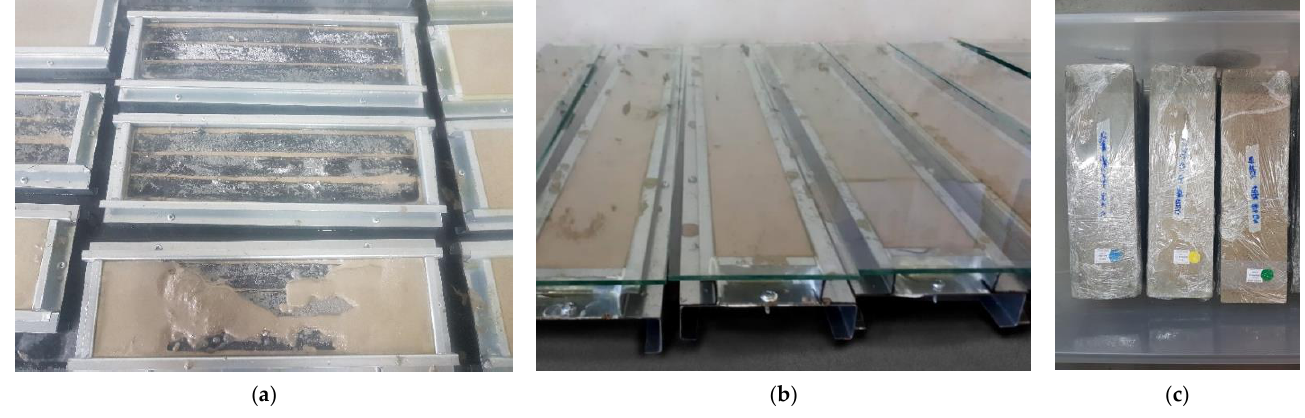
Figure 3. ( a ) The preparation of samples: bottom lightweight concrete layer according to the level marked on the metallic form, positioning of polyester strips, and filling of top lightweight concrete layer; ( b ) closed form with glass; ( c ) test bodies demolded after 72 h, wrapped in plastic wrap, and stored in closed plastic containers with a layer of water at the bottom.